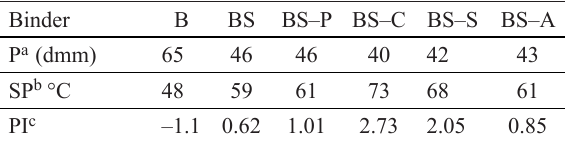
Table 7. Results of conventional bitumen tests